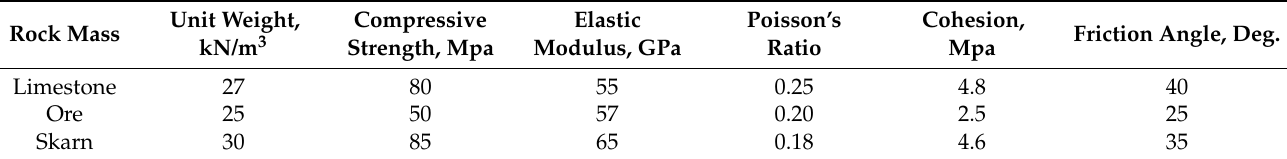
Figure 13. ( a ) 3D perspective view of open pit case study. ( b ) 2D plan section. Table 5. Geomechanical properties of rock masses of open pit case study